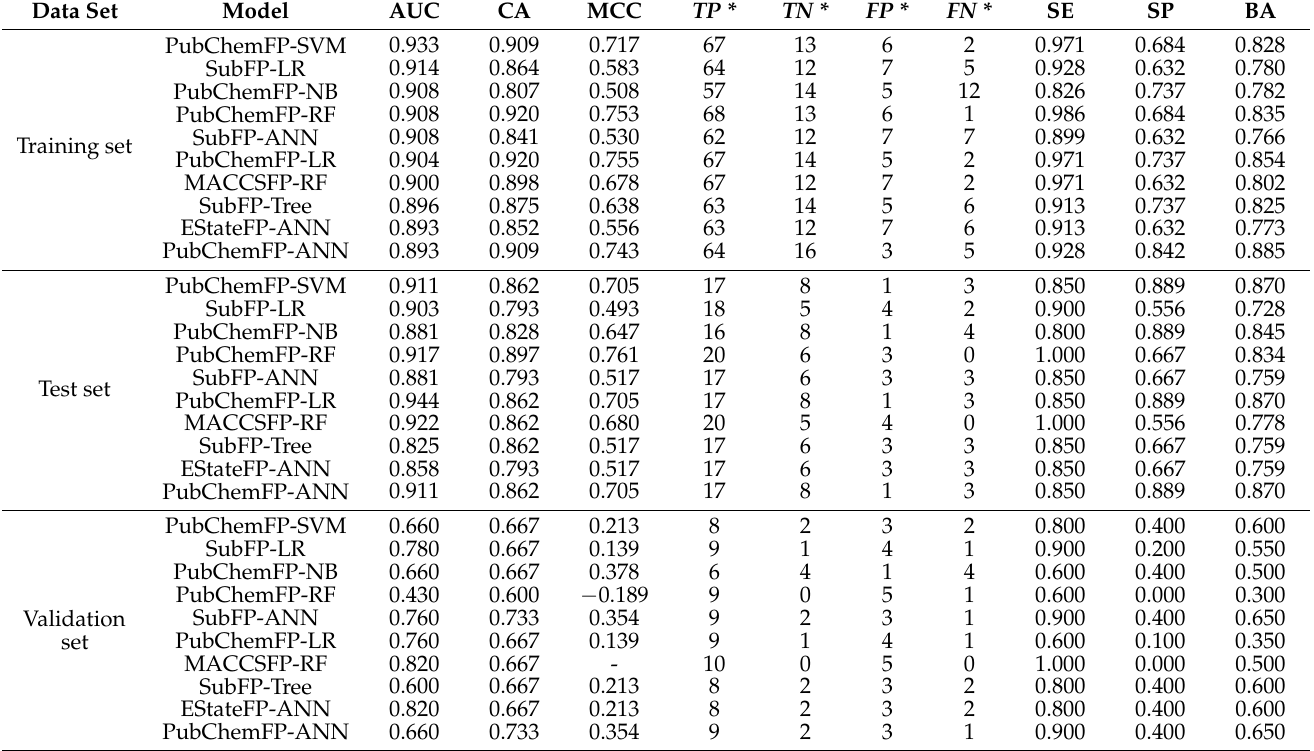
Table 1. Performance of top 10 models for the training set, test set, and external validation